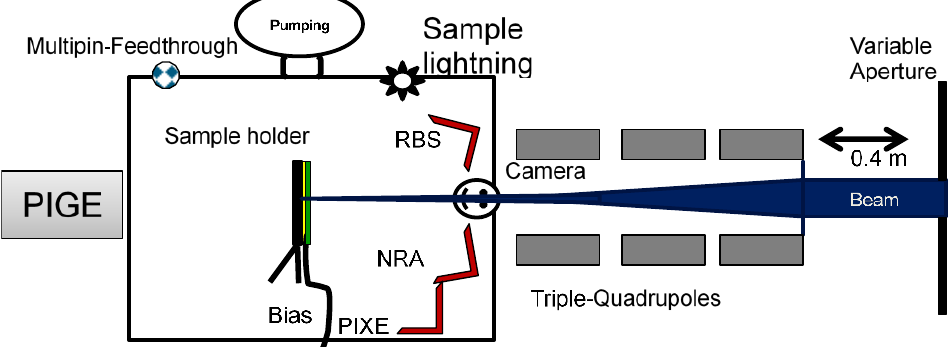
Figure 7. Sketch of the detector and chamber arrangement.